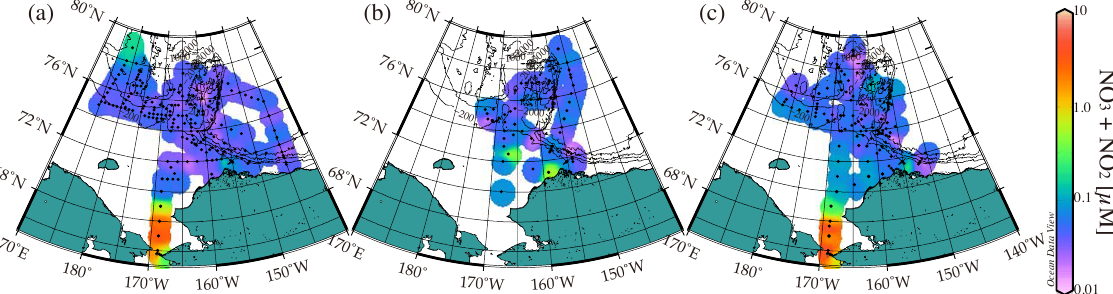
Fig. 5. Surface distribution of NO 3 + NO 2 in the western Arctic Ocean during late summer in (a) 2008, (b) 2009 and (c) 2010. Black dots indicate the sampling stations visited during the cruises. Depth contours indicate 50-, 100-, 500-, 1000- and 3000-m intervals.